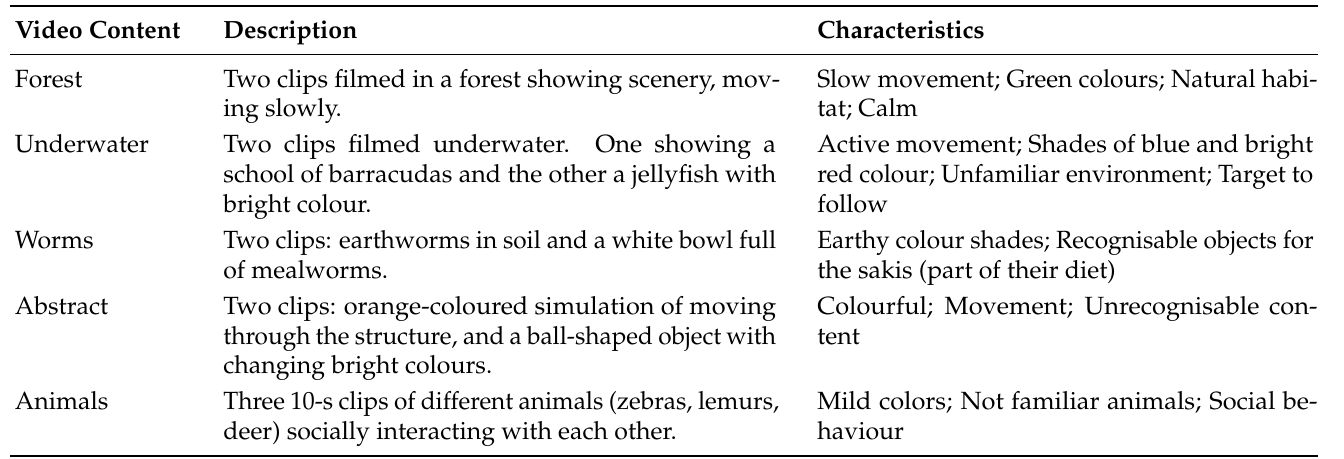
Figure 4. Stills of the videos played to sakis including Adobe Premier Pro vectorscope of hue and saturation. Rows 1: forest video, 2: underwater video, 3: abstract video, 4: worms video, and 5-6: animals video. Table 1. Visual stimuli